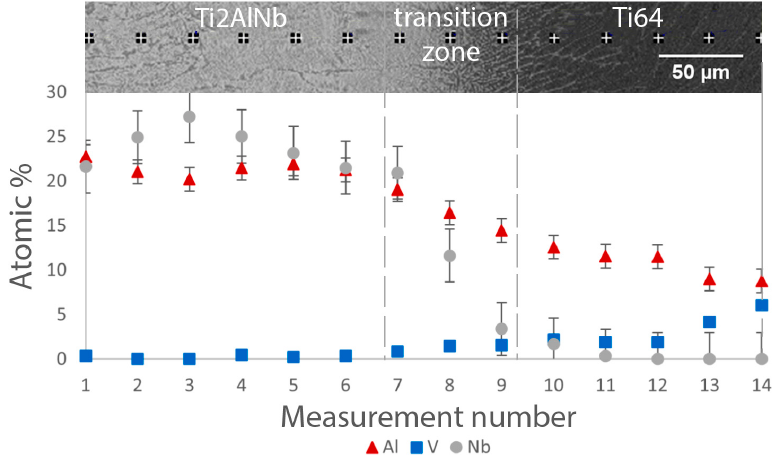
Figure 6. Variation of Al, V, and Nb content along the transition zone for the bimetallic sample produced with platform preheating after annealing (Type B).